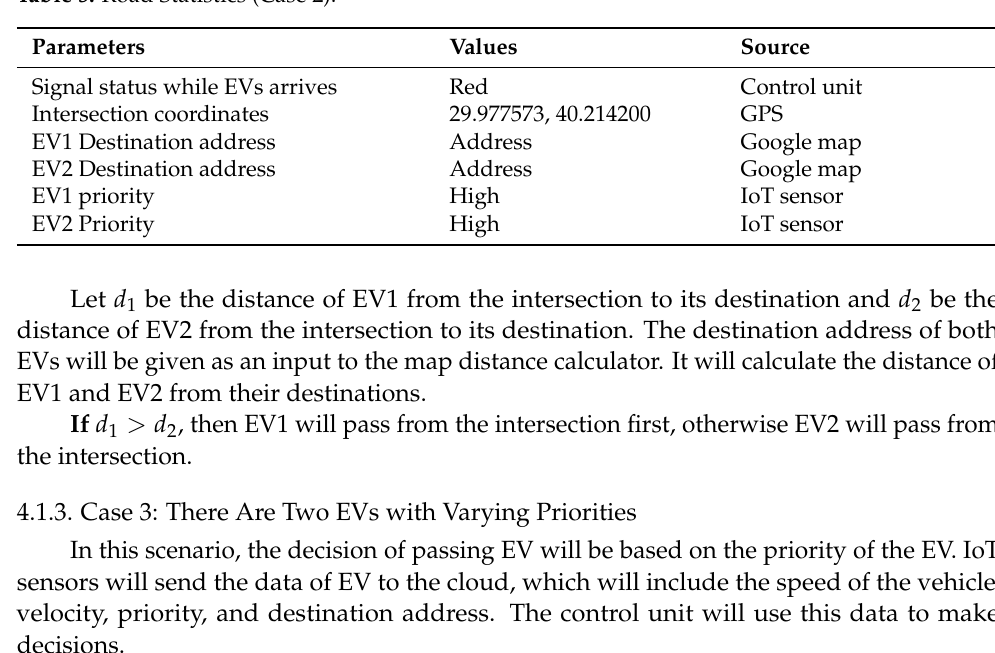
Table 5. Road Statistics (Case